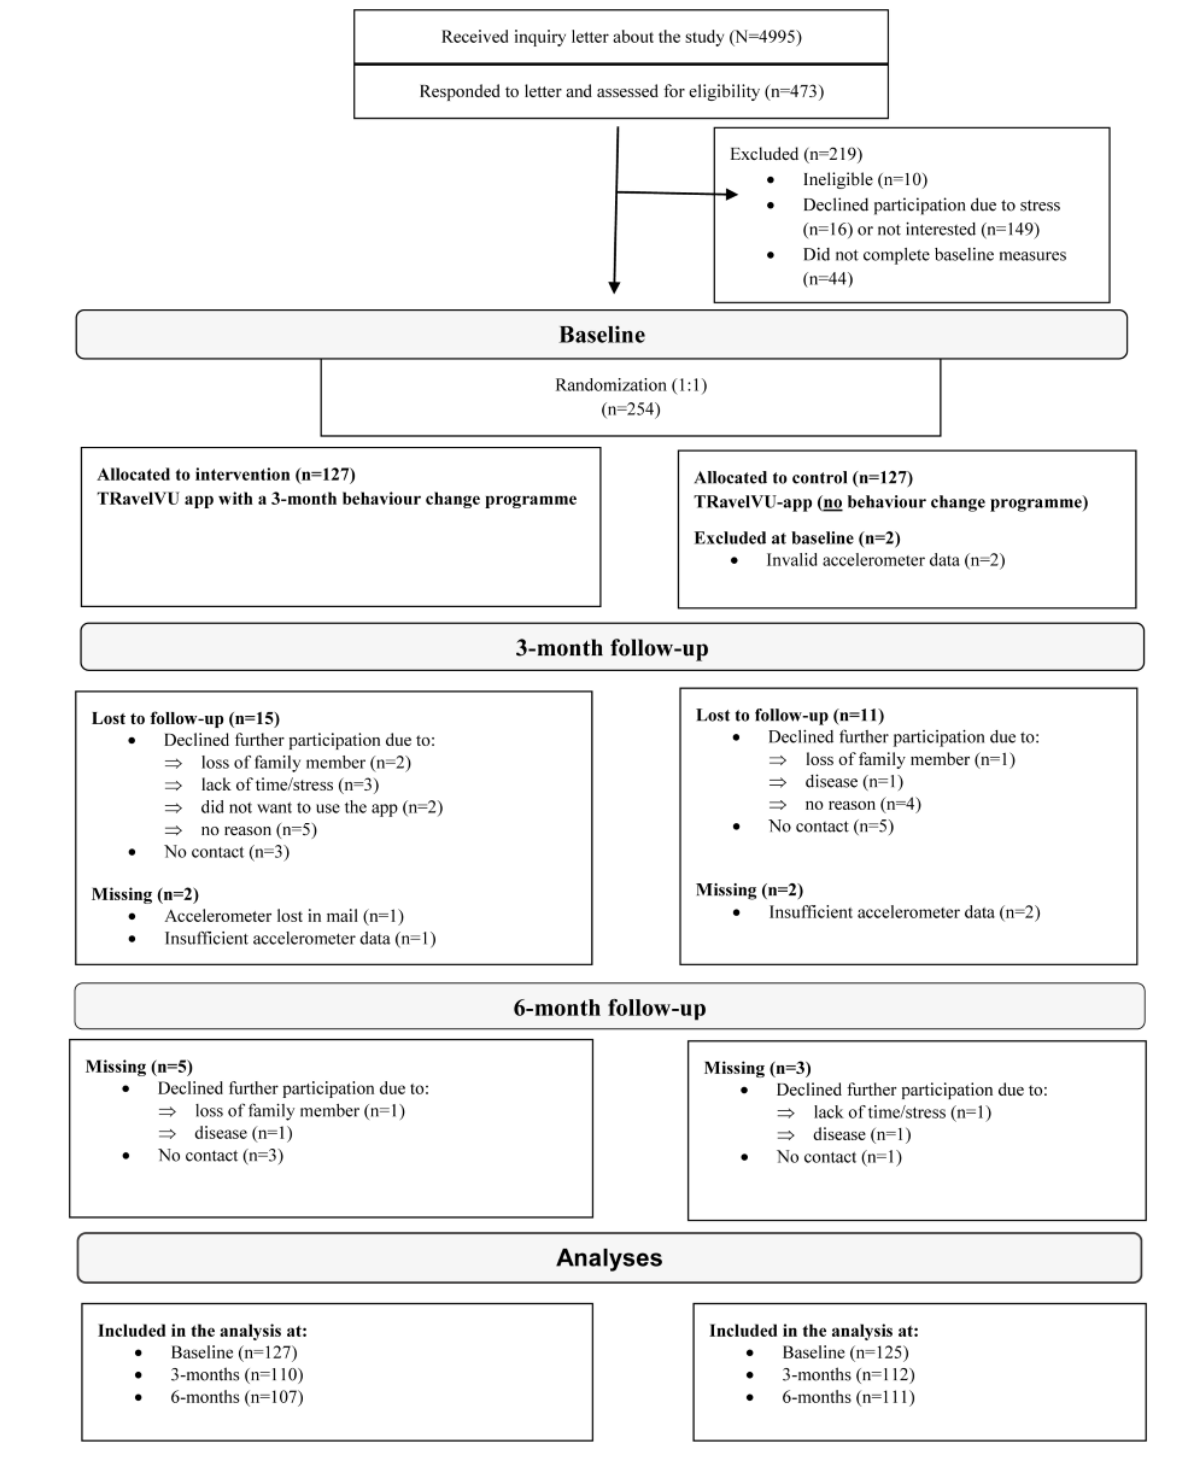
Figure 2. Flowchart of the Smart City Active Mobile Phone Intervention